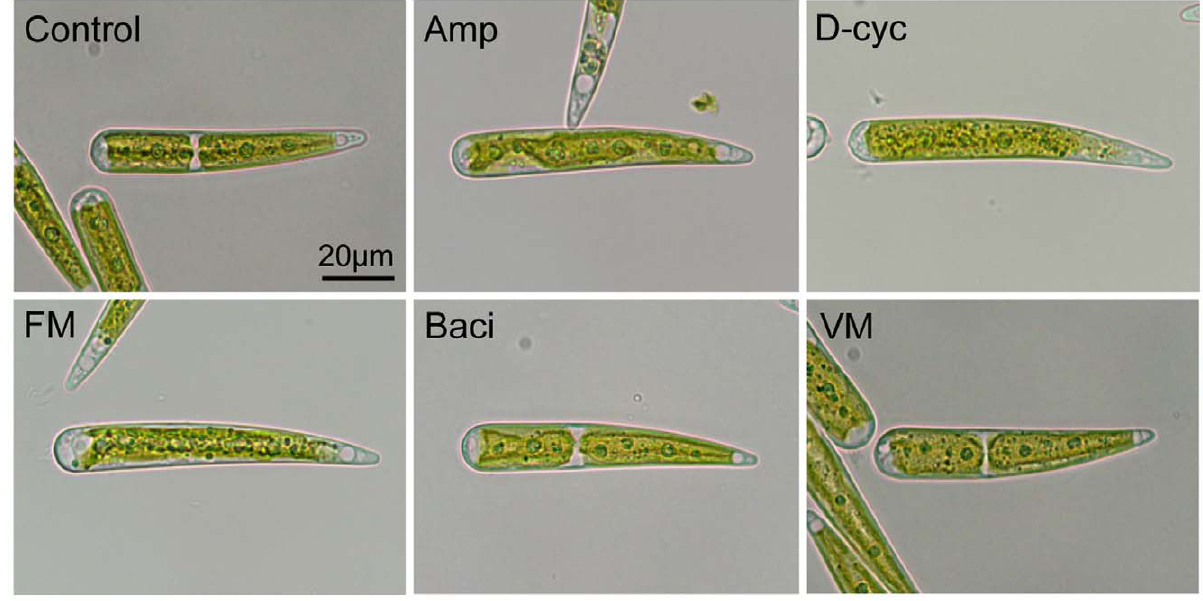
Figure 2. Effects of antibiotics on Closterium cells. Addition of colchicine led to production of tadpole-shaped cells by inhibiting cell elongation after division. These cells were easy to distinguish from normal crescent-shaped cells. Without antibiotics (Control), cells had two chloroplasts. When Closterium cells were treated with 100 m M ampicillin (Amp), 100 m M D-cycloserine (D-cyc), or 250 m M fosfomycin (FM), cells with only one chloroplast appeared. On the other hand, 100 m M bacitracin (Baci) and vancomycin (VM) did not affect the number of chloroplasts.